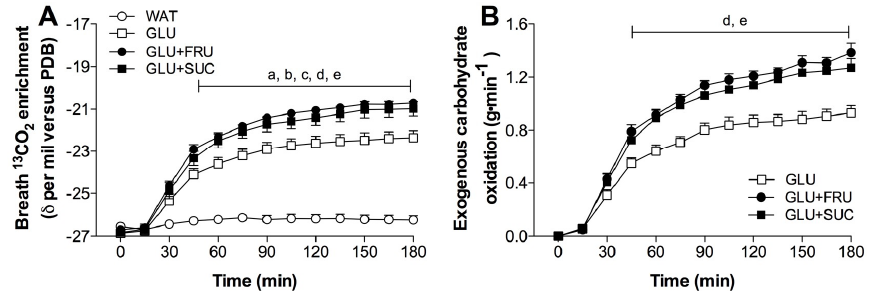
Figure 1. Breath 13 CO 2 enrichments ( A ) and exogenous carbohydrate oxidation rates ( B ) during exercise without ingestion of carbohydrate (WAT), with the ingestion of glucose (GLU), with the ingestion of glucose and fructose (GLU + FRU), or with the ingestion of glucose and sucrose (GLU + SUC). Data were analsysed with a two-way repeated measures ANOVA (time-treatment). Data are presented as means ± SEM. N = 10. a, denotes GLU significantly different from WAT; b, denotes GLU + FRU significantly different from WAT; c, denotes GLU + SUC significantly different from WAT; d, denotes GLU + FRU significantly different from GLU; e, denotes GLU + SUC significantly different from GLU ( p < 0.05).